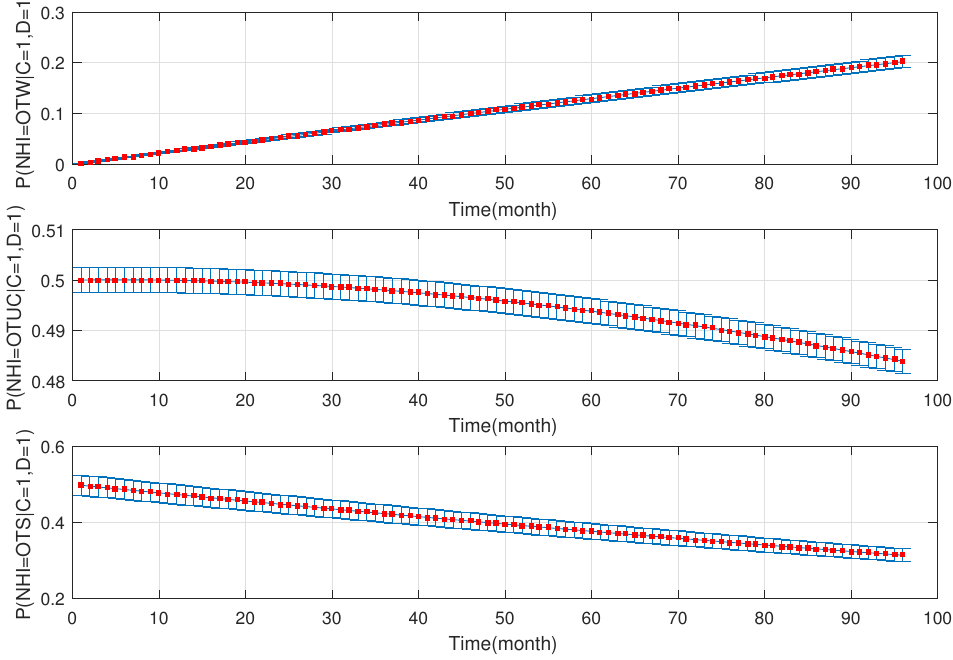
Figure 18. The probability of new herd incident (NHI) (officially TB free status withdrawn (OTW), officially TB free status unclassified (OTUC), officially TB free status suspended (OTS)) in edge-risk areas of England where C: manure storage over 6 months; and D: stock density is more than 3 head/km − 2 in the presence of the rest of risk factors (A: cattle are over 24 months; B: Badger density ≤ 3 heads/ha; S: silage fed; and W: the number of purchased cattle is more than 50